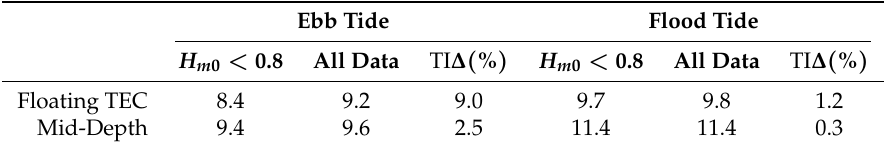
Table 5. Streamwise Turbulence Intensity (TI) values with and without data exclusion based on contemporaneous wave measurement for a single summer D-ADP deployment. TI ∆ is a relative percentage difference. Ebb Tide Flood Tide H m 0 < 0.8 All